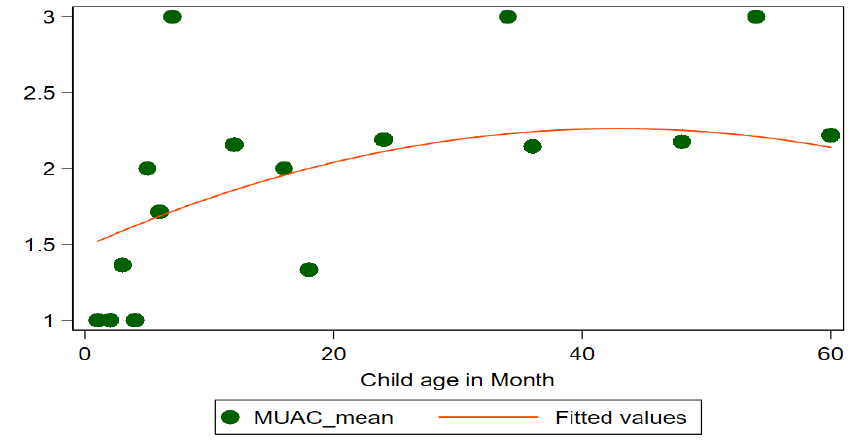
Figure 3. Mean Z − Scores (MUAC) by age in months.